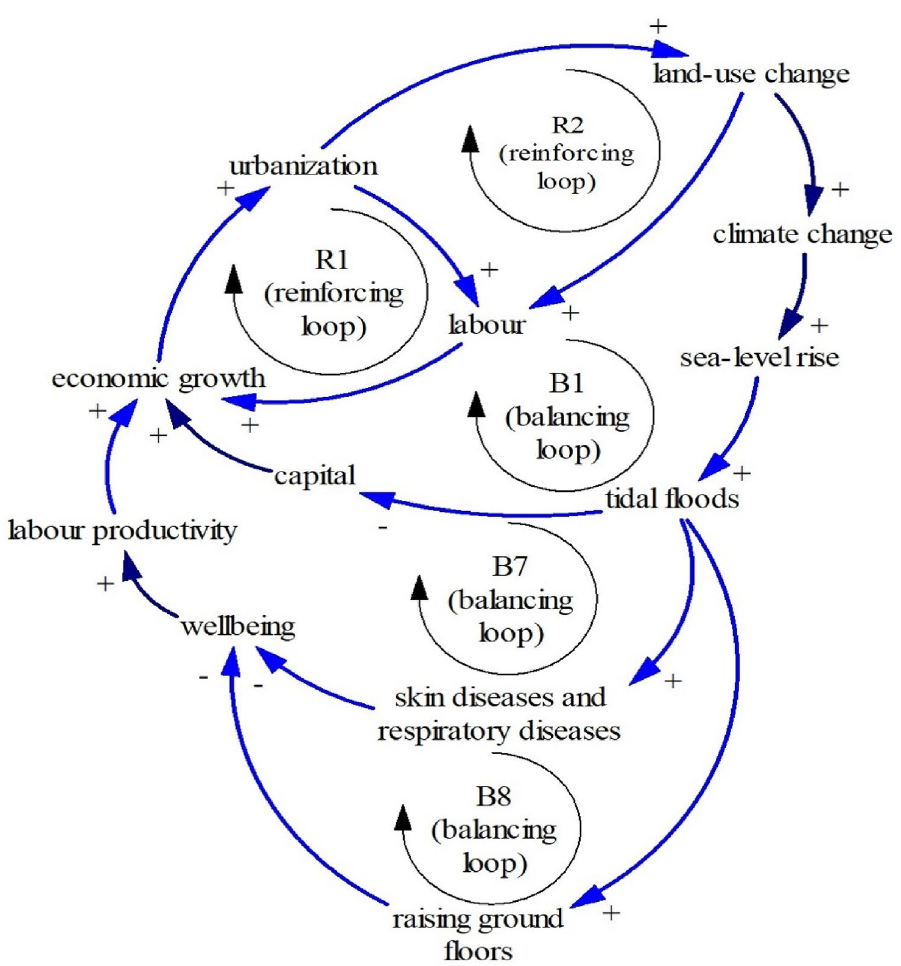
Figure 15. The Limits to Growth